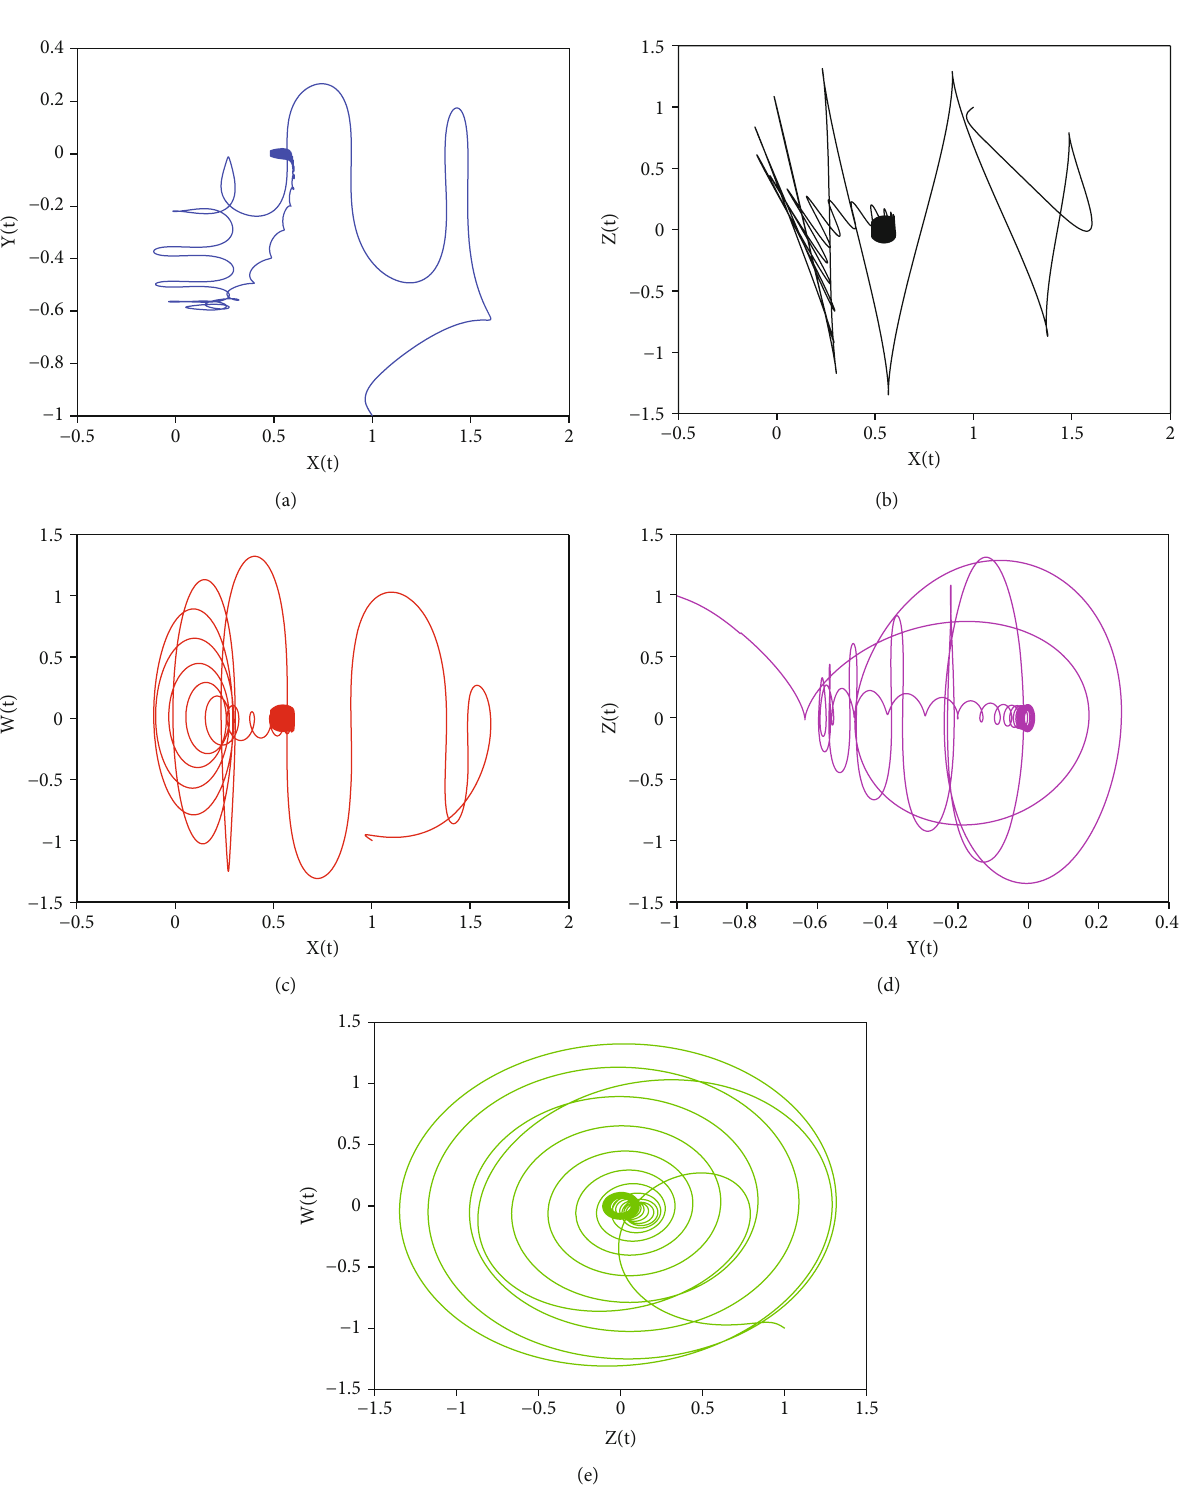
Figure 12: The behavior of di ff erent state variables of system 2 with fractional order ϖ = 0 : 98 and the parameters are considered as m = n = 5